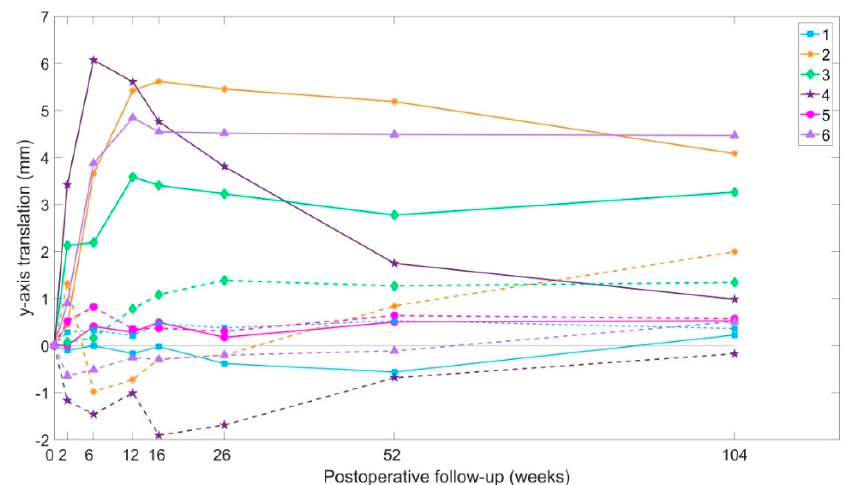
Figure 5. Proximal (Y-axis) translations over time. Continuous lines indicate displacements of the injured side ilium. Dotted lines indicate displacements of the non-injured side ilium.